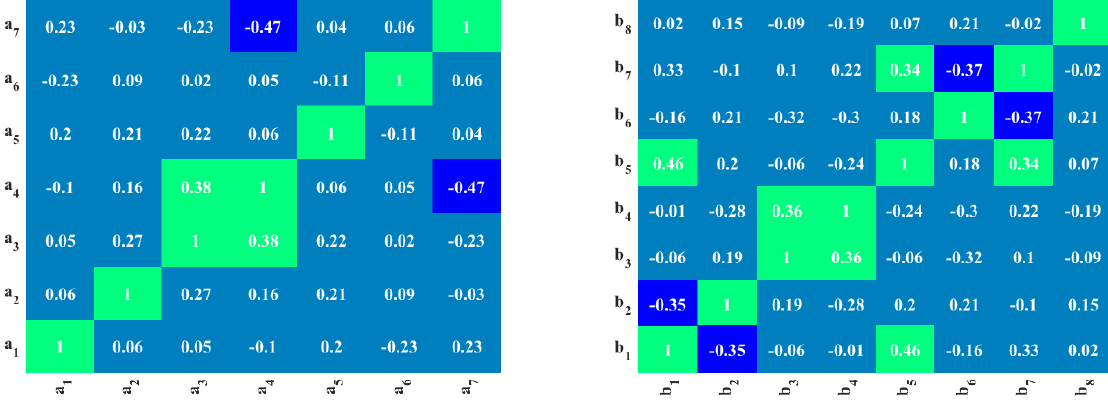
Figure 4. p -value of mixed indicators of PE and IC failure. Figure 4. P -value of mixed indicators of PE and IC failure. Grey correlation analysis is used to determine the degree of influence of each factor